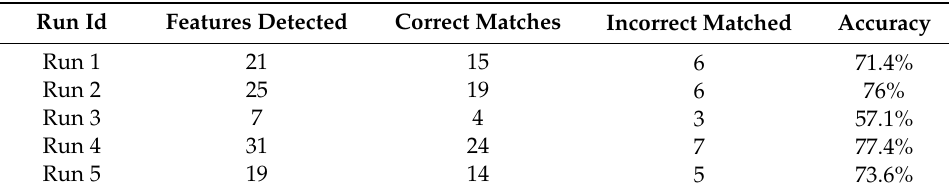
Table 1. Feature Descriptor